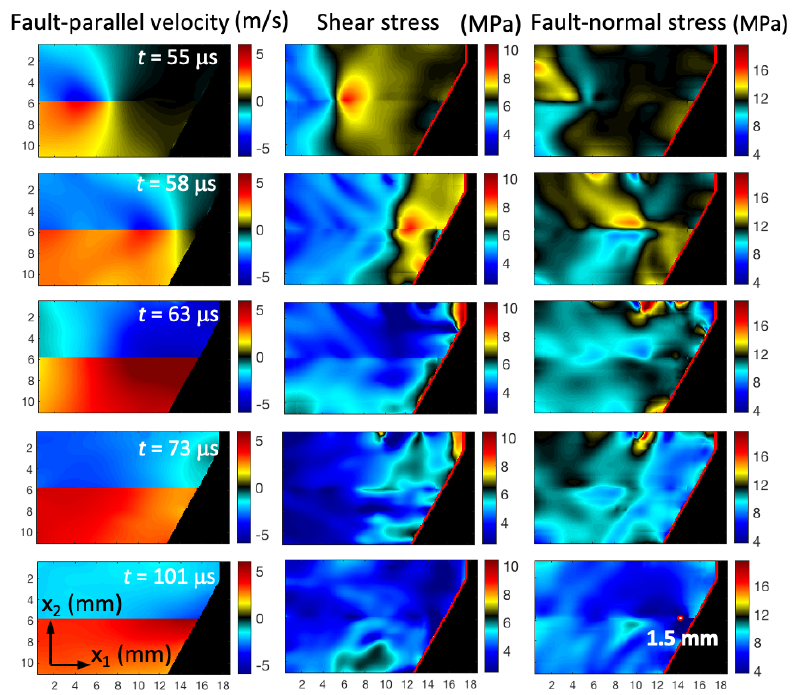
Fig. 3. Full-field of measurements capturing rupture propagation near the free surface with the associated normal stress reduction and shear stress evolution. Full-field interface-parallel velocity (left), shear stress (middle), and interface-normal stress (right) at different stages of a supershear crack-like rupture for a test with a = 29 o , P = 15 MPa, and field of view of 18.7 x 11.7 mm. The first four rows correspond to stages when the rupture arrives to and is reflected from the free surface, while the last row corresponds to the arrival of the trailing Rayleigh